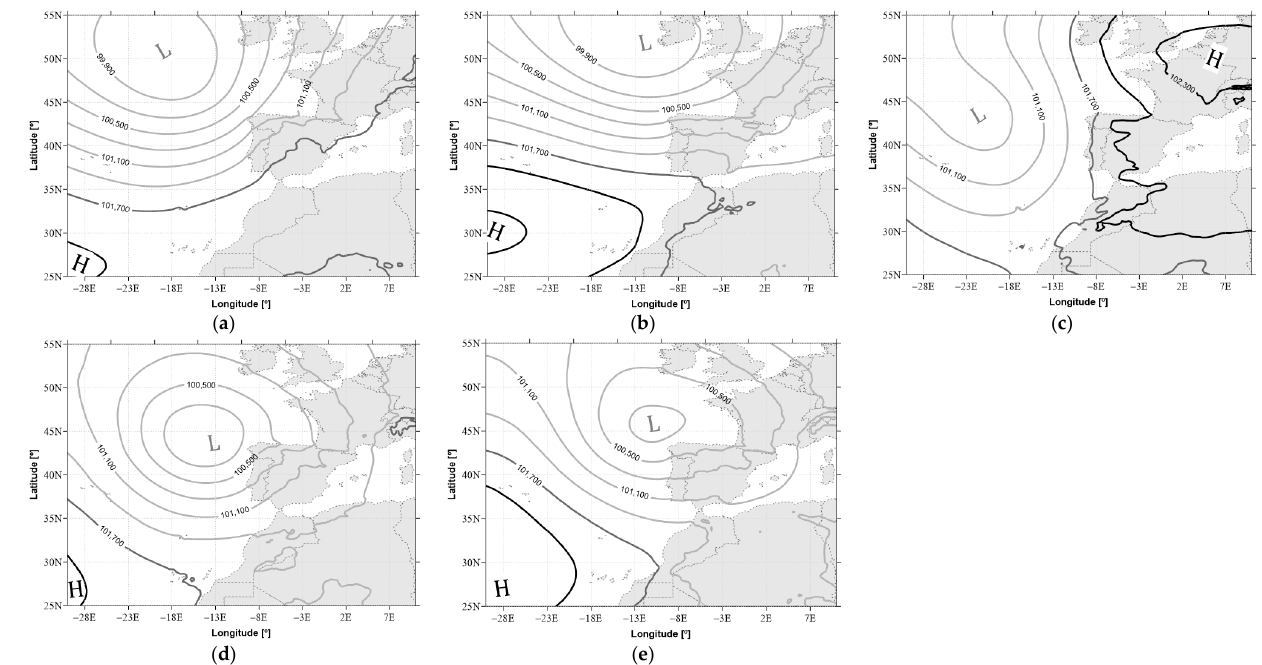
Figure 8. Mean sea level pressure (Pa) contour maps representative of the most dominant weather circulation types over the region under study often associated with severe weather in mainland Portugal. Period from 1980 to 2018: ( a ) “SW”—southwest circulation, ( b ) “W”—west circulation, ( c ) “S”—south circulation, ( d ) “L + SW”—hybrid low pressure with southwest circulation, and ( e ) “L + W”—hybrid low circulation with west circulation. The contour lines are gradational by color (grey—low-pressure areas, black—high-pressure areas) and equally spaced by 300 (Pa). The letters H and L in all images identify the center with high- or low-pressure values.